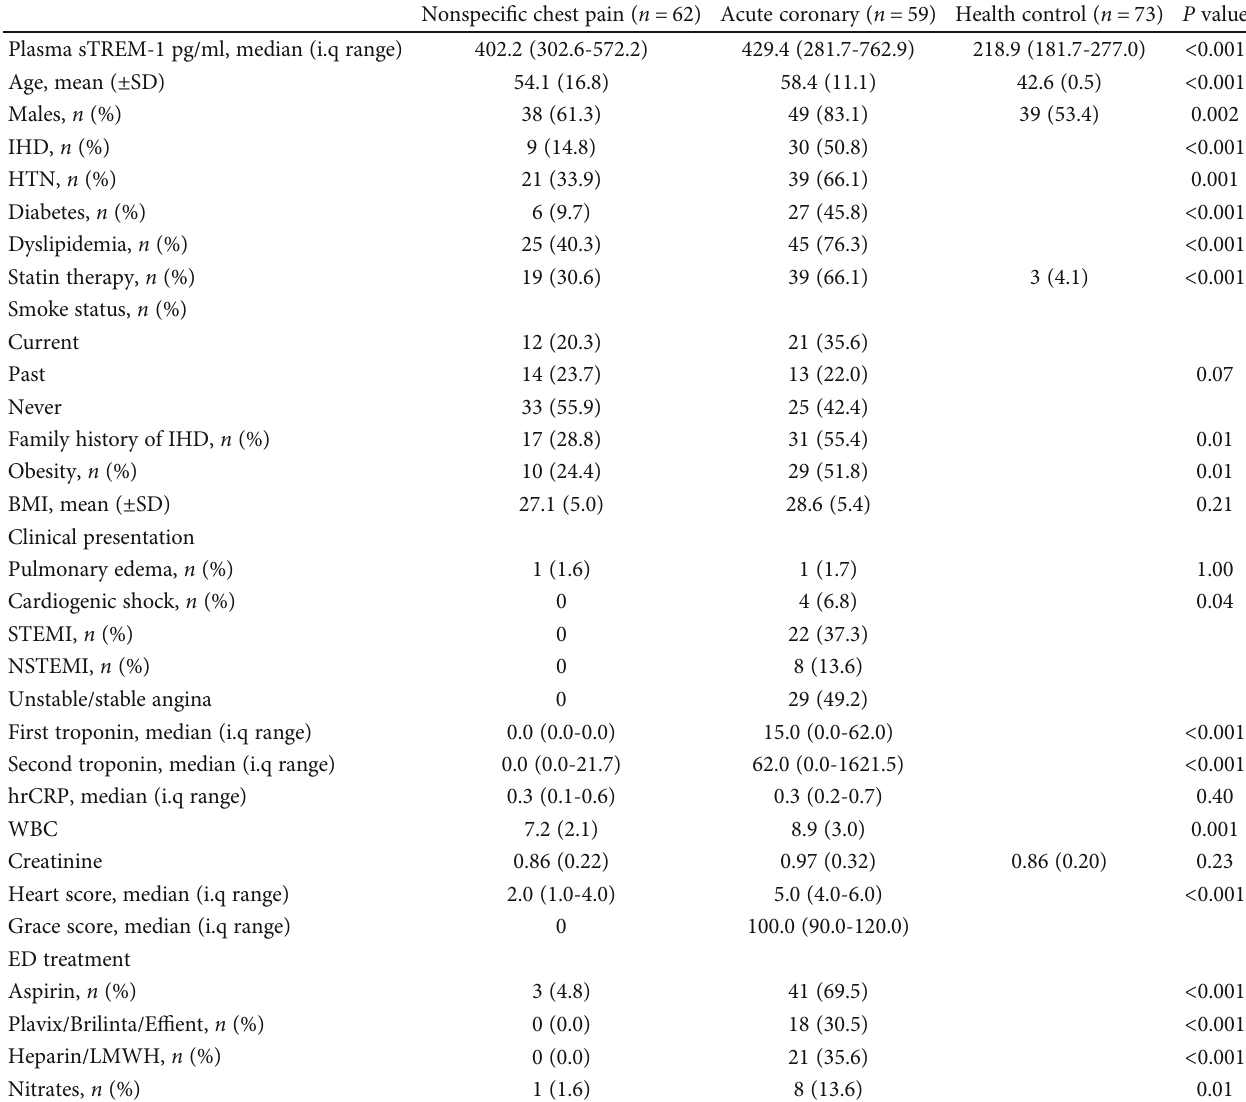
Table 1: Epidemiological characteristics of the study